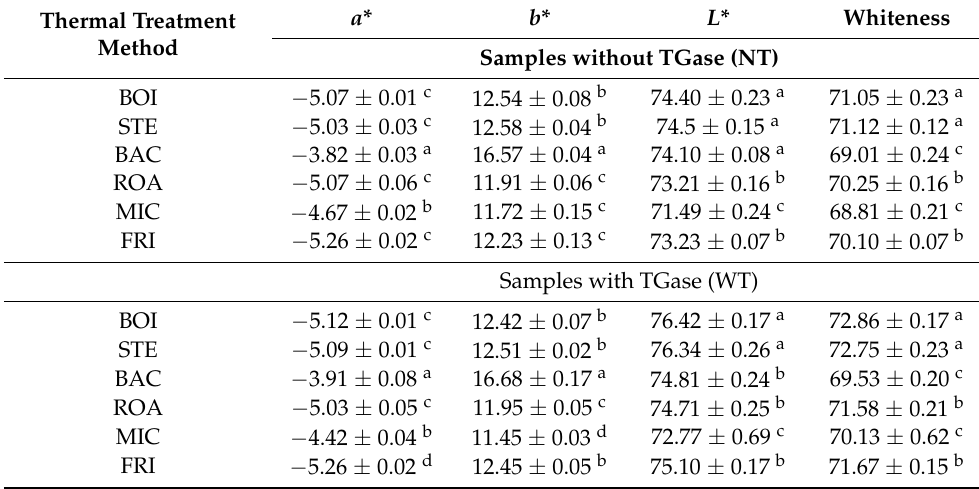
Table 4. Different thermal treatment methods and the addition of TGase affect the brightness and whiteness of D. maruadsi surimi